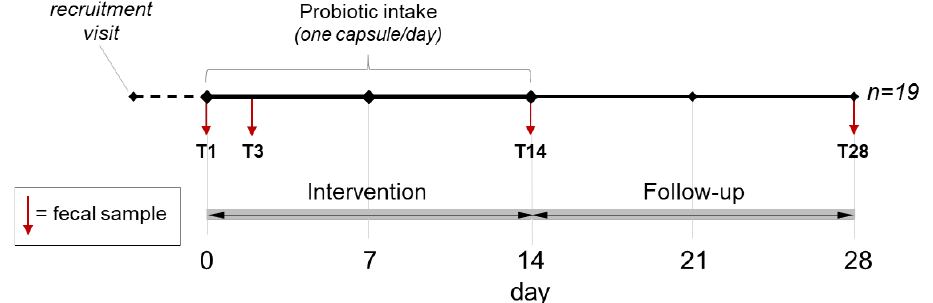
Figure 1. Design of the trial. Vertical arrows indicate the collection and analysis of fecal samples in this study. T3 corresponds to the fecal sample collected between days 3 and 5, depending on the subject (day 3 for most of the volunteers).